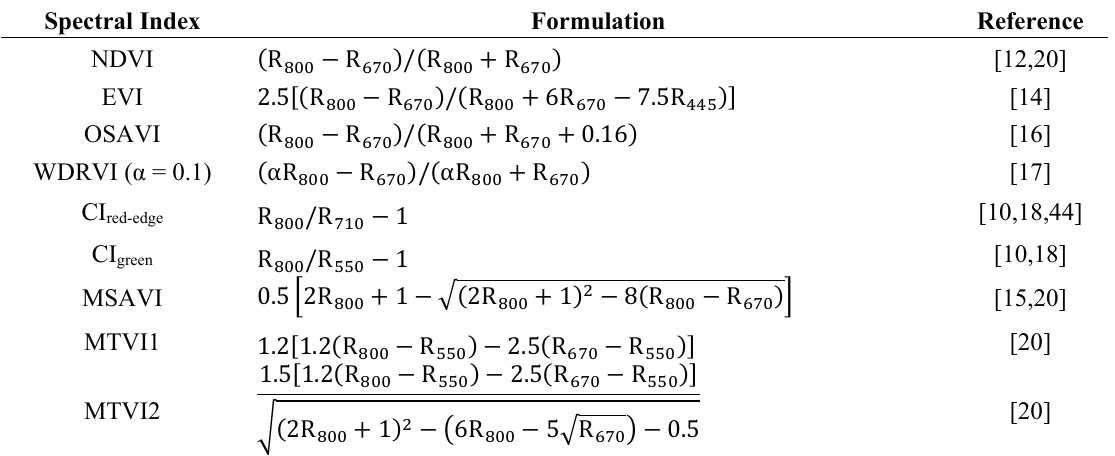
Table 3. Existing spectral indices (SIs) used for comparison with the DSI, RSI, and